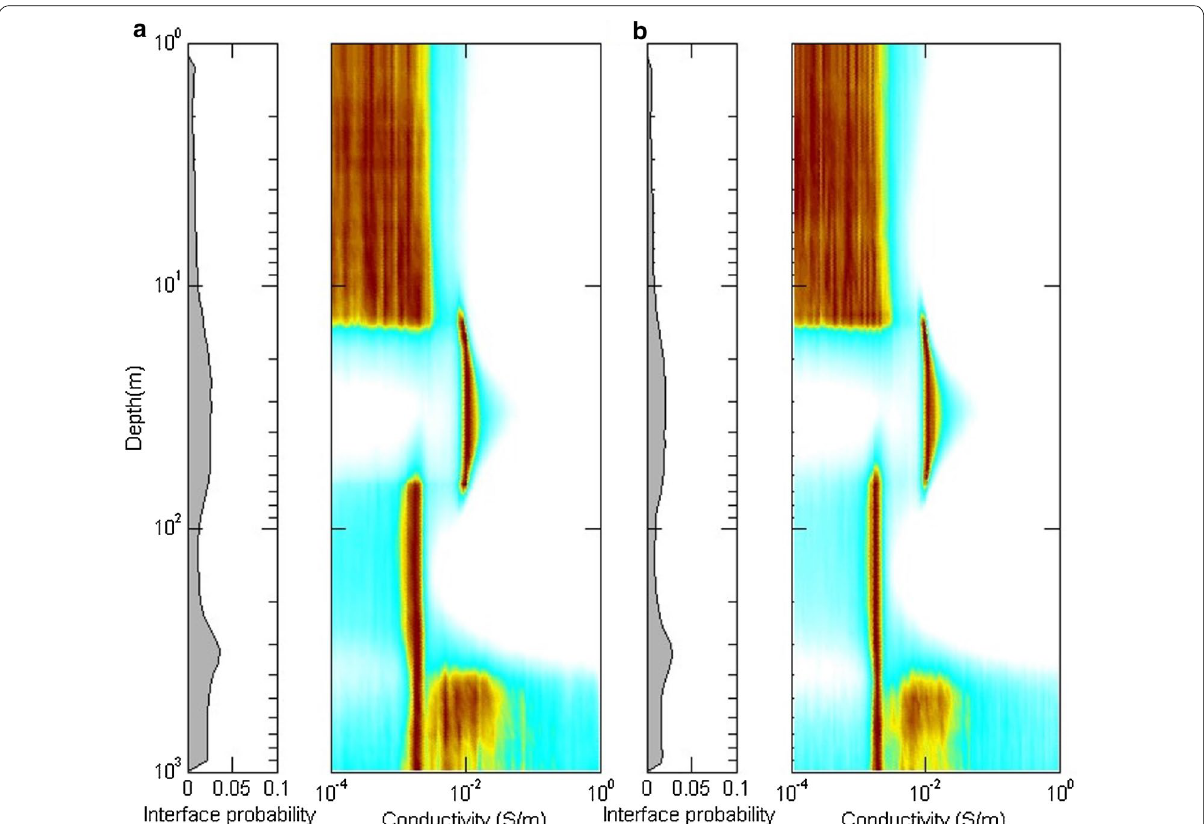
Fig. 6 Marginal profiles of the interface depth and conductivity for the COPROD1 data from the inversions ( a ) with and ( b ) without considering error